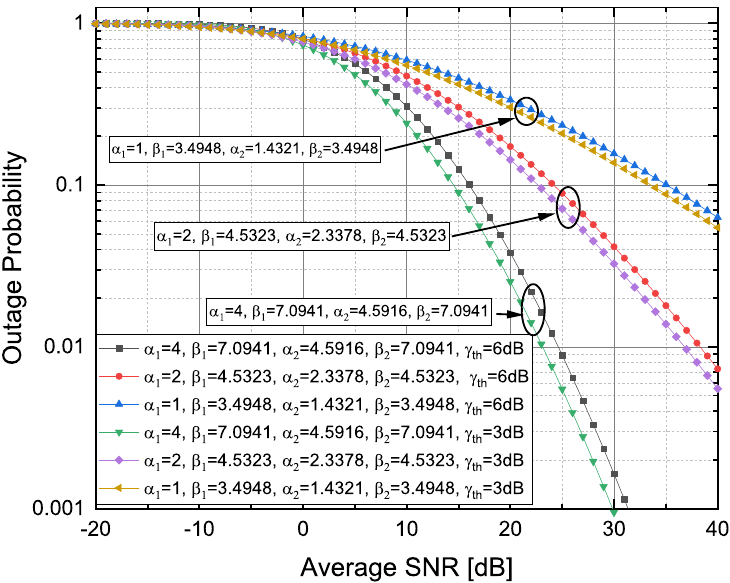
Figure 3. Outage probability versus ¯ γ th observed for different TI fading severity conditions. The P BER ( γ ) versus ¯ γ for a 1 = 6, b 1 = 2.58, a 2 = 5.75, b 2 = 2.58 and a 1 = 3, b 1 = 2.1, a 2 = 2.73 and b 2 = 2.1 TI fading severity values [13], where a 1 was an inte- ger, and for the selected binary modulation schemes such as BFSK, BPSK, NBFSK and DBPSK are presented in Figure 4. It was obvious that less severe TI fading conditions provided a lower P BER ( γ ) (e.g., by shifting from a 1 = 3, b 1 = 2.1, a 2 = 2.73 and b 2 = 2.1 to a 1 = 6, b 1 = 2.58, a 2 = 5.75 and b 2 = 2.58). It can be further concluded that, for higher dB ¯ γ values, TI fading conditions had a stronger impact on the P BER ( γ ) than the observed modulation